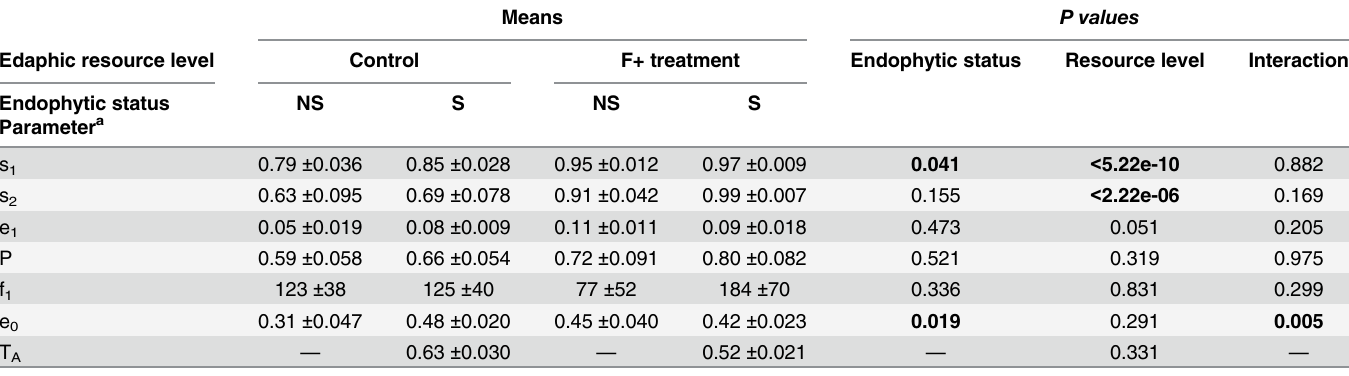
Table 2. Mean and results of deviance analysis for the parameters of the models of Festuca eskia population dynamics. The values shown are means ± SEM.